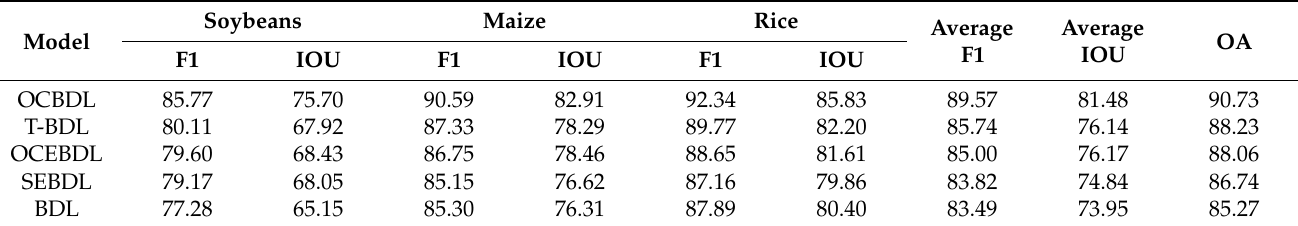
Table 3. Evaluation metric results for the ablation experiments.